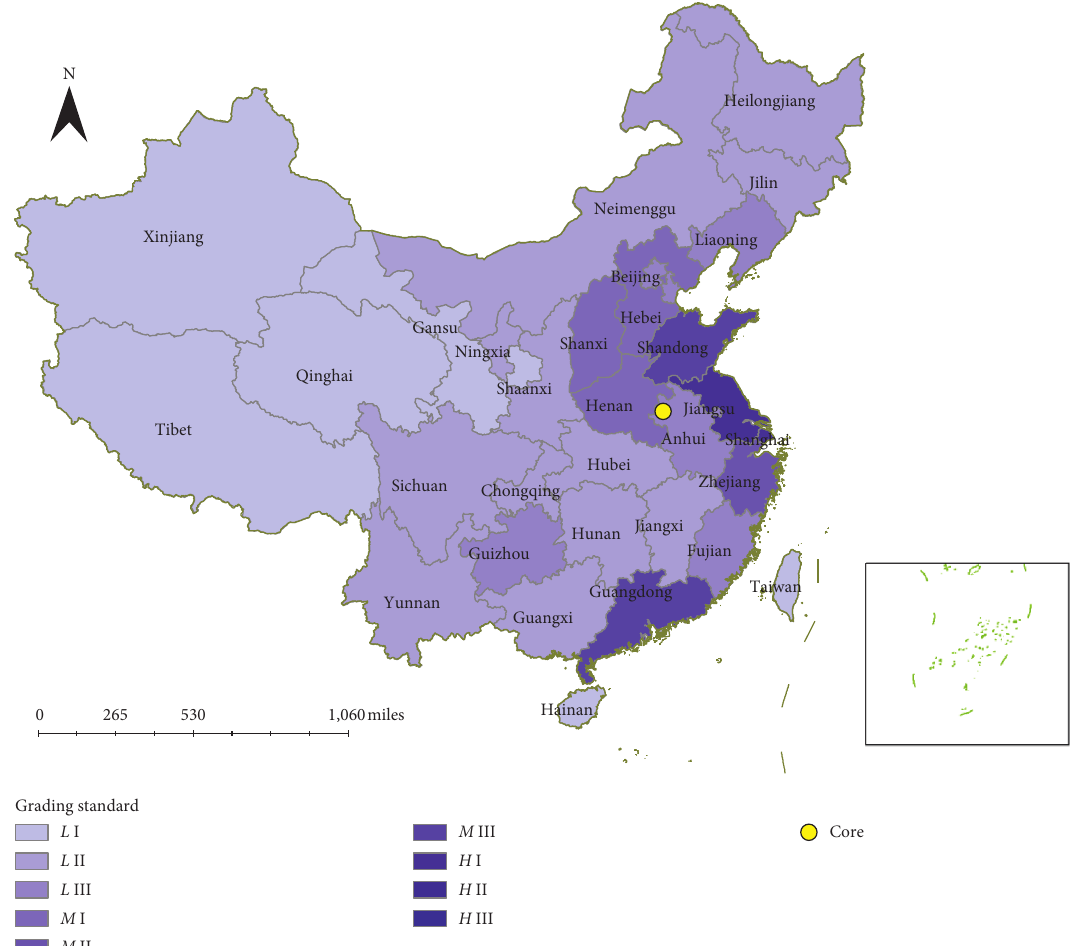
Figure 3: Depth distribution map of power carbon footprint of China’s provinces in 2008. Note. The yellow dot is the average center, i.e., density center, calculated according to the power carbon footprint and coordinates of each province, which is used to represent the concentration area of carbon footprint. The principle and calculation method of the geographical average center can be found in literature